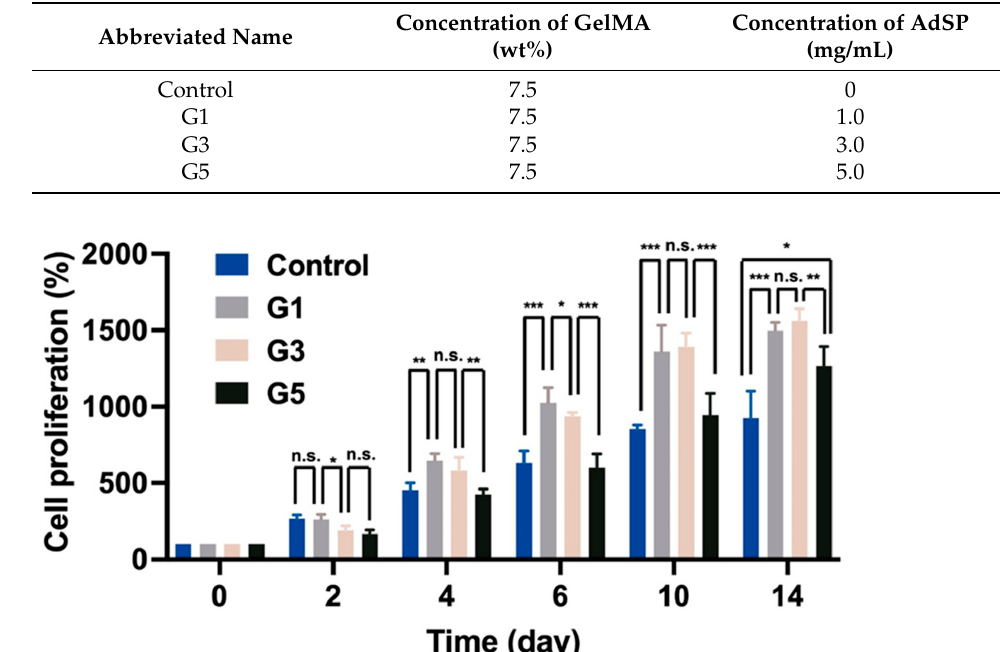
Figure 2. The proliferation of neural stem cells (NSCs) encapsulated in different hydrogels for a period of 14 days. * p < 0.05, ** p < 0.01, and *** p < 0.001 between the indicated